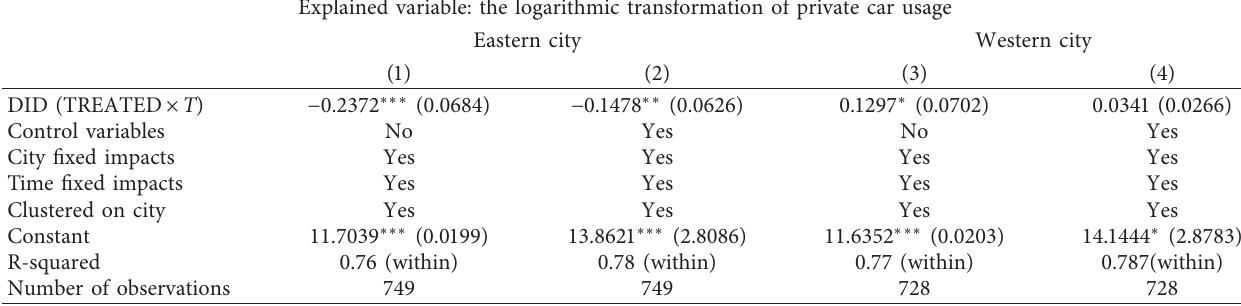
Table 11: Analysis of urban location heterogeneity. Explained variable: the logarithmic transformation of private car